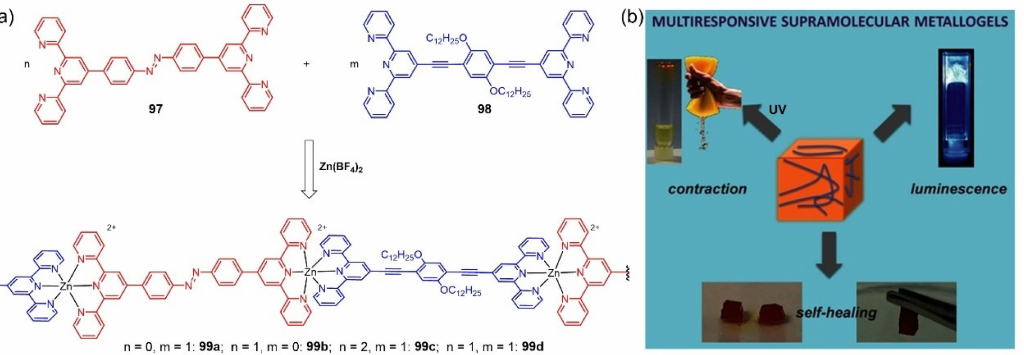
Figure 42. ( a ) The structures of metallo-copolymers 99 . ( b ) Schematic representation of the smart properties, including light-powered actuation, photoluminescence and self-healing. Reprinted with permission from Ref. [121]. Copyright (2016), John Wiley and